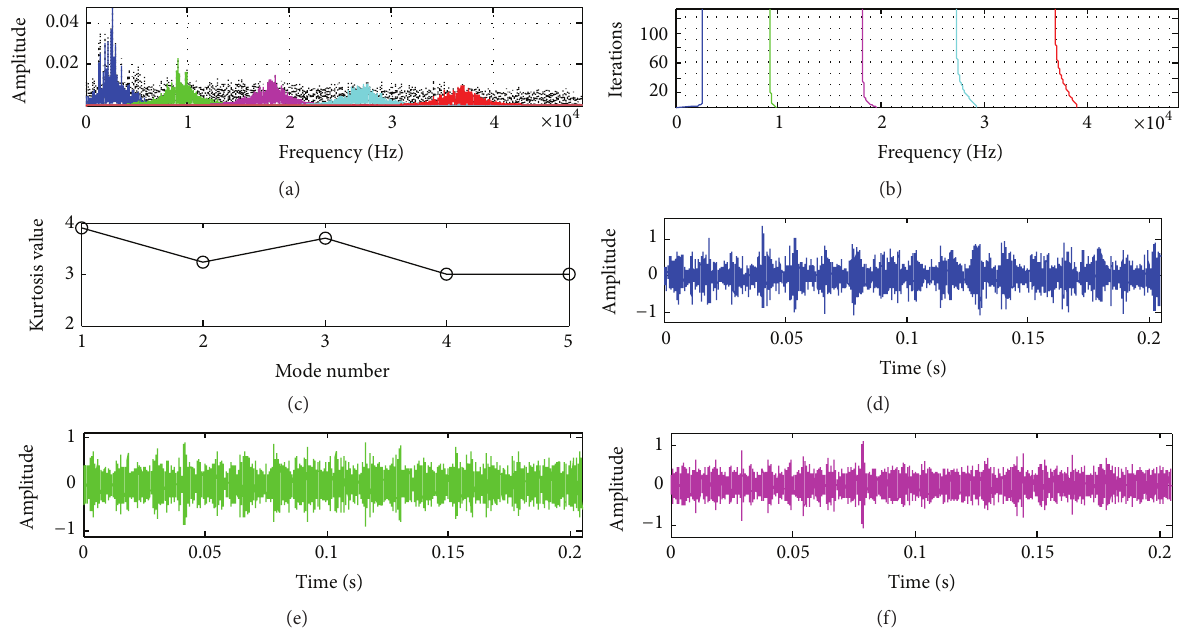
Figure 16: Analyzed results of the experimental vibration signal in Figure 15(a) by the proposed method: (a) power spectrum of five modes decomposed by VMD; (b) the number of iterations with central frequencies; (c) kurtosis value of five decomposed modes; (d) waveform of the first mode with the maximum kurtosis value; (e) waveform of the second mode with the third maximum kurtosis value; (f) waveform of the third mode with the second maximum kurtosis value.